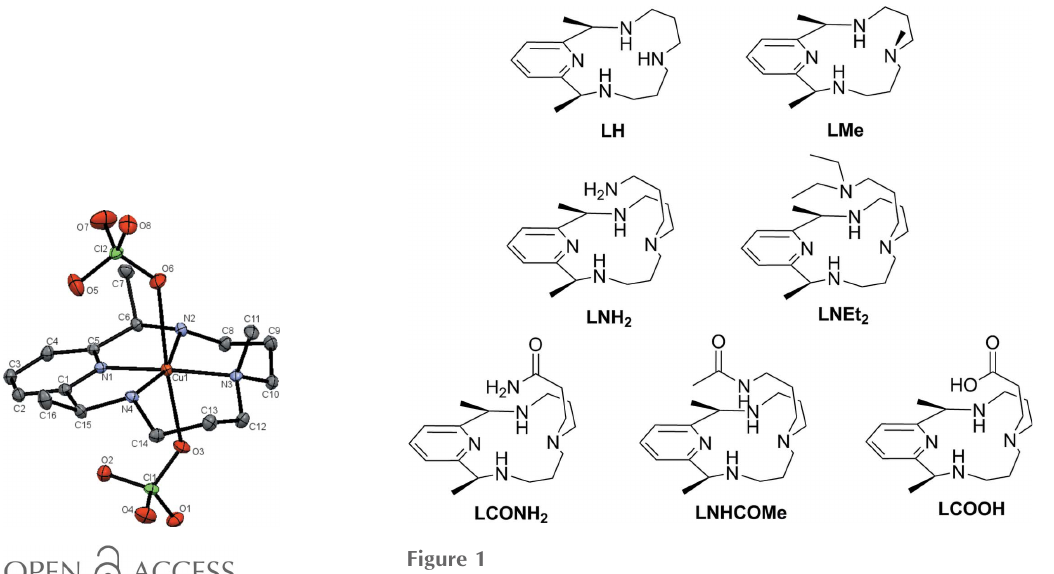
Figure 1 Pyridine-containing macrocycles